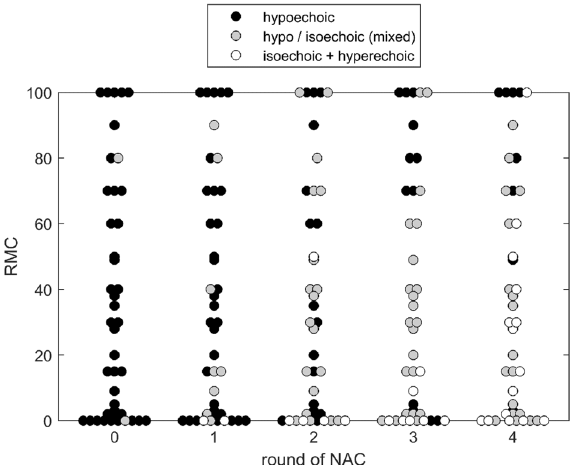
Figure 1. The RMC (%) value of tumour in relation to tumour echogenicity after subsequent courses of NAC. Measurements were determined before the treatment (0) and after subsequent NAC courses (from 1 to 4). Isoechoic and hyperechoic tumours (echogenicity levels 3 and 4) are presented together due to low number of the latter. (One case of hyperechoic tumour was observed after the 3rd and two after the 4th NAC course).